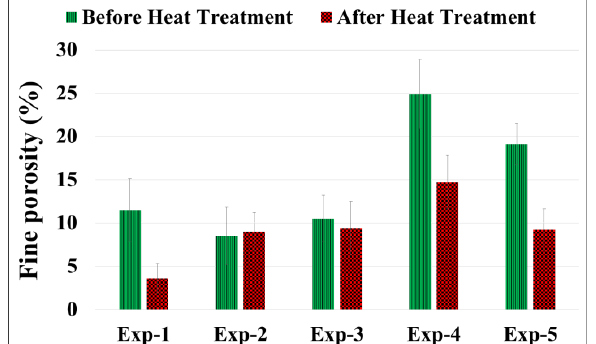
Figure 6. Fine porosity content in % area for all coatings before and after heat treatment.